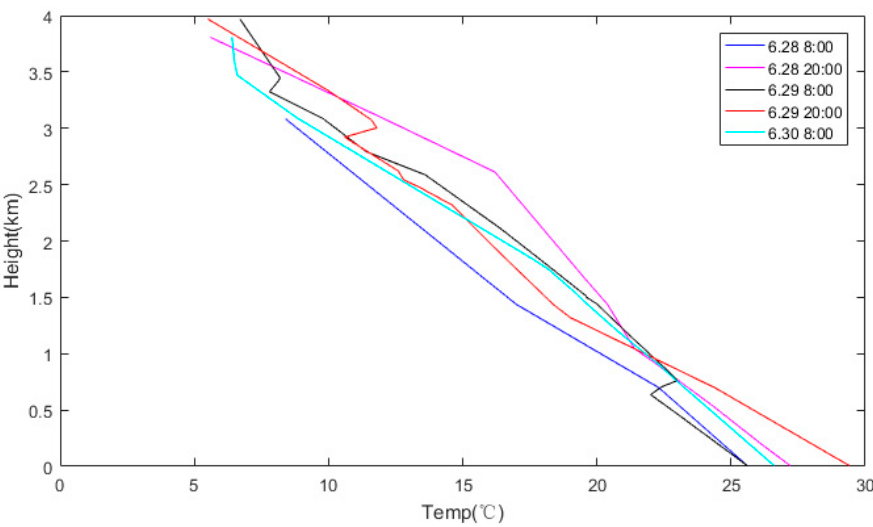
Figure 13. Nanjing station upper air sounding temperature stratification curves, at 08:00 and 20:00 on June